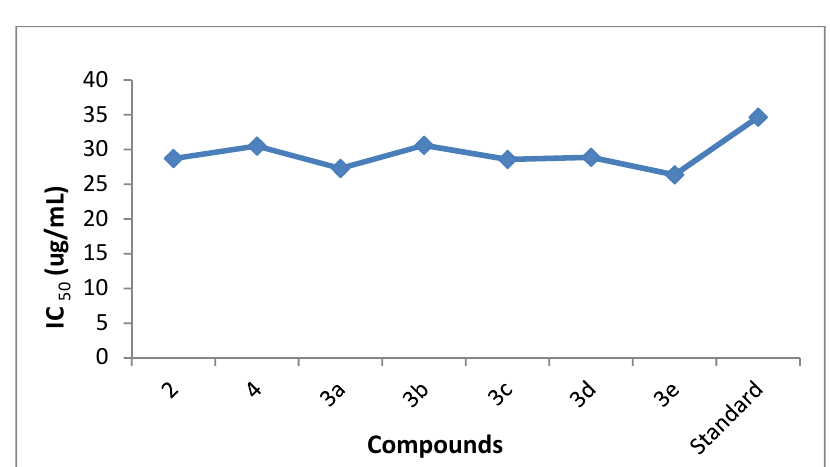
Figure 2. IC values of anti-urease 50